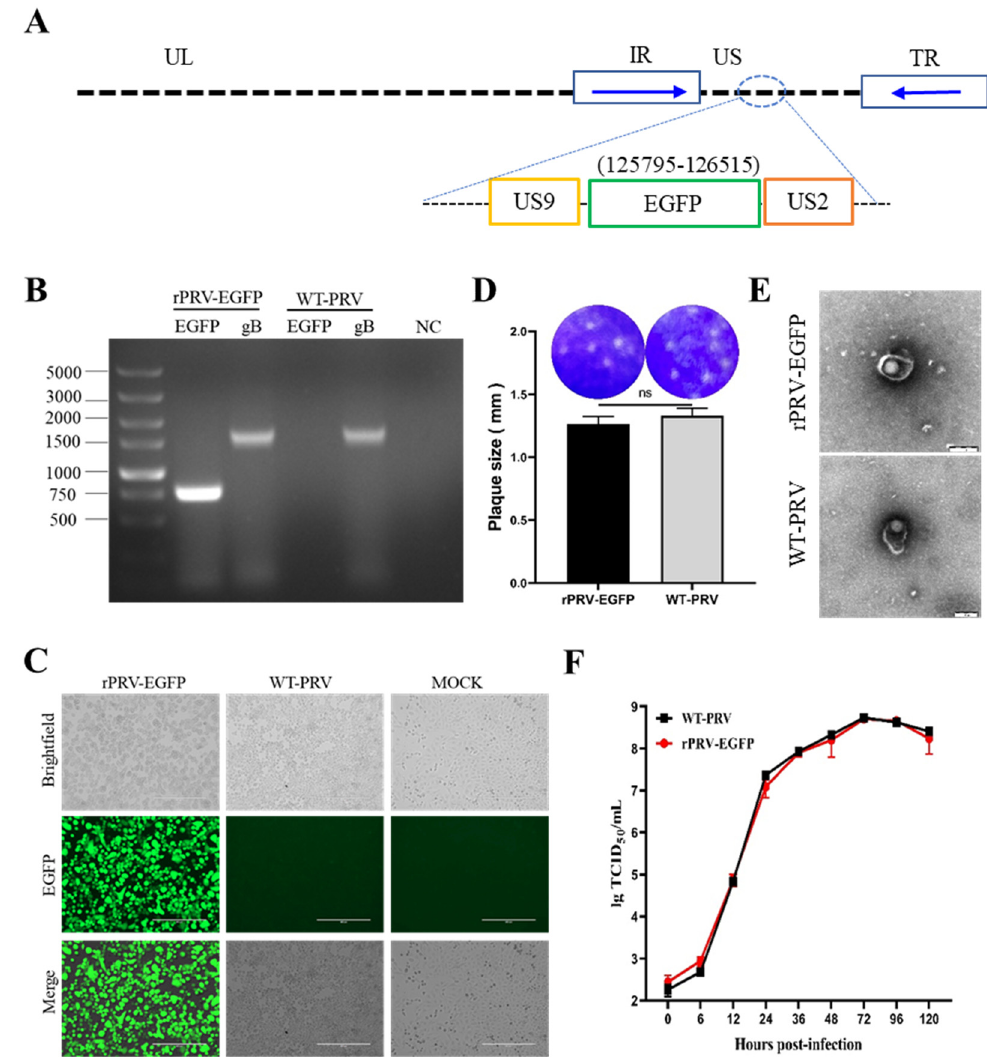
Figure 1. Generation and characterization of rPRV-EGFP. ( A ) Schematic diagram of the construction of the recombinant virus. Using the PRV genomic fosmid library, the EGFP sequence was inserted nondestructively downstream of the US9 gene in the PRV genome. The relative position of the EGFP sequence in the WT-PRV genome is shown on top of the green box. ( B ) PCR amplification of the EGFP and gB genes from the genomes of rPRV-EGFP and WT-PRV. ( C ) The green fluorescence and cytopathic effects (CPEs) in the PK-15 cells infected with rPRV-EGFP and WT-PRV at 48 h postinfection (hpi). ( D ) Plaques of rPRV-EGFP and WT-PRV in the PK-15 cells. ns: not significant ( p ≥ 0.05).The diameters of plaques were averaged for three independent experiments. ns: not significant. ( E ) Transmission electron microscopy photographs of rPRV-EGFP and WT-PRV. Scale bar = 200 nm. ( F ) One-step growth curves of rPRV-EGFP and WT-PRV in PK-15 cells.